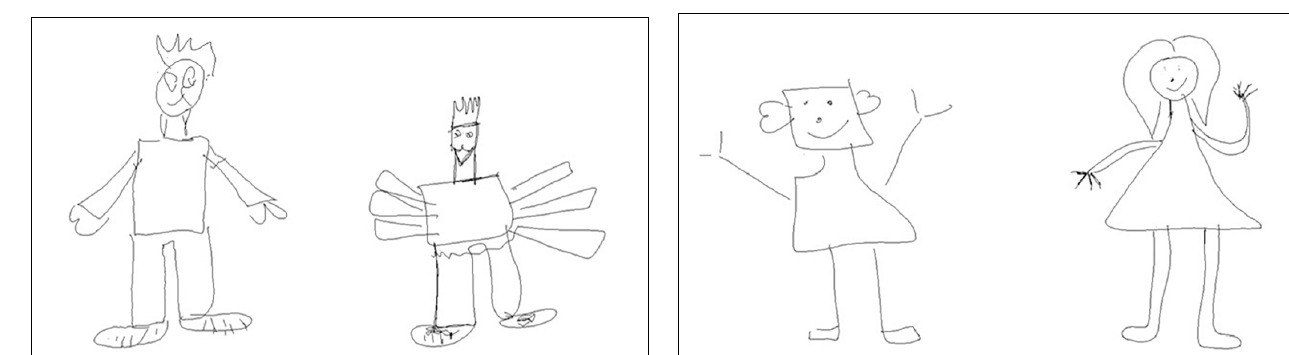
FIGURE 2 | Example of shape modification of elements in stylus drawing on tablet at 6th grade: compared to the unoriginal drawing (on the left), the shape of the head and of the trunk has been modified in the original drawing (on the